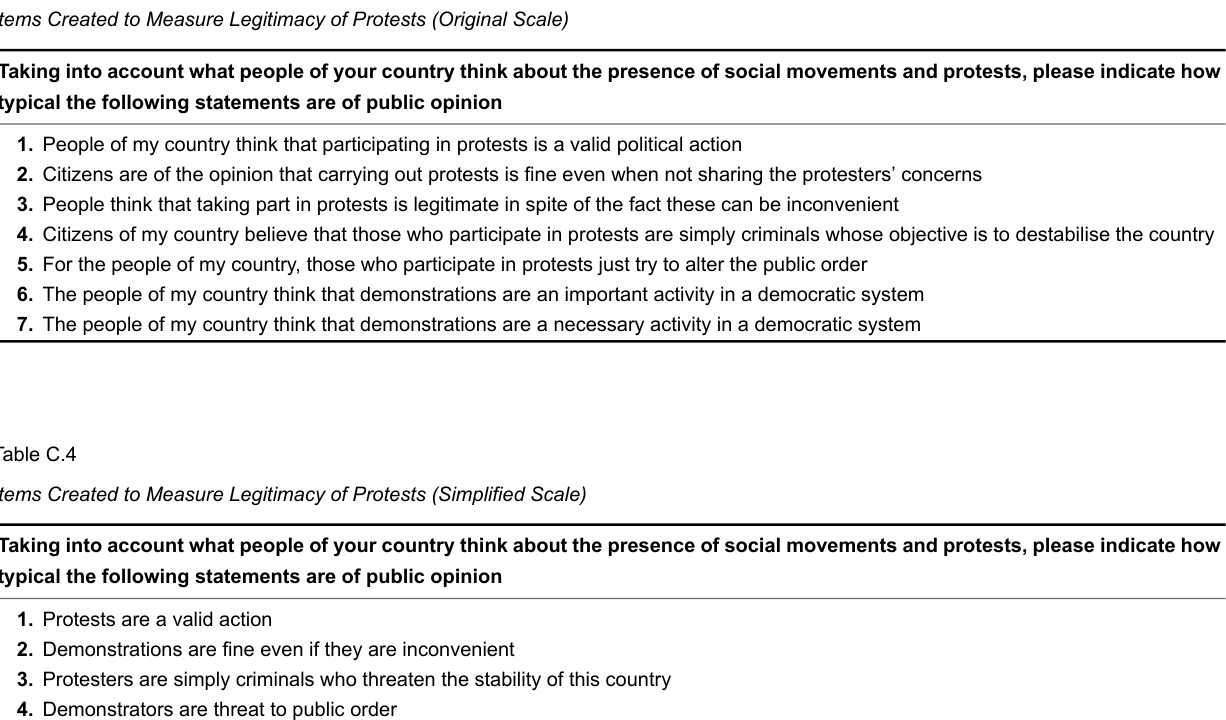
Items Created to Measure Legitimacy of Protests (Original